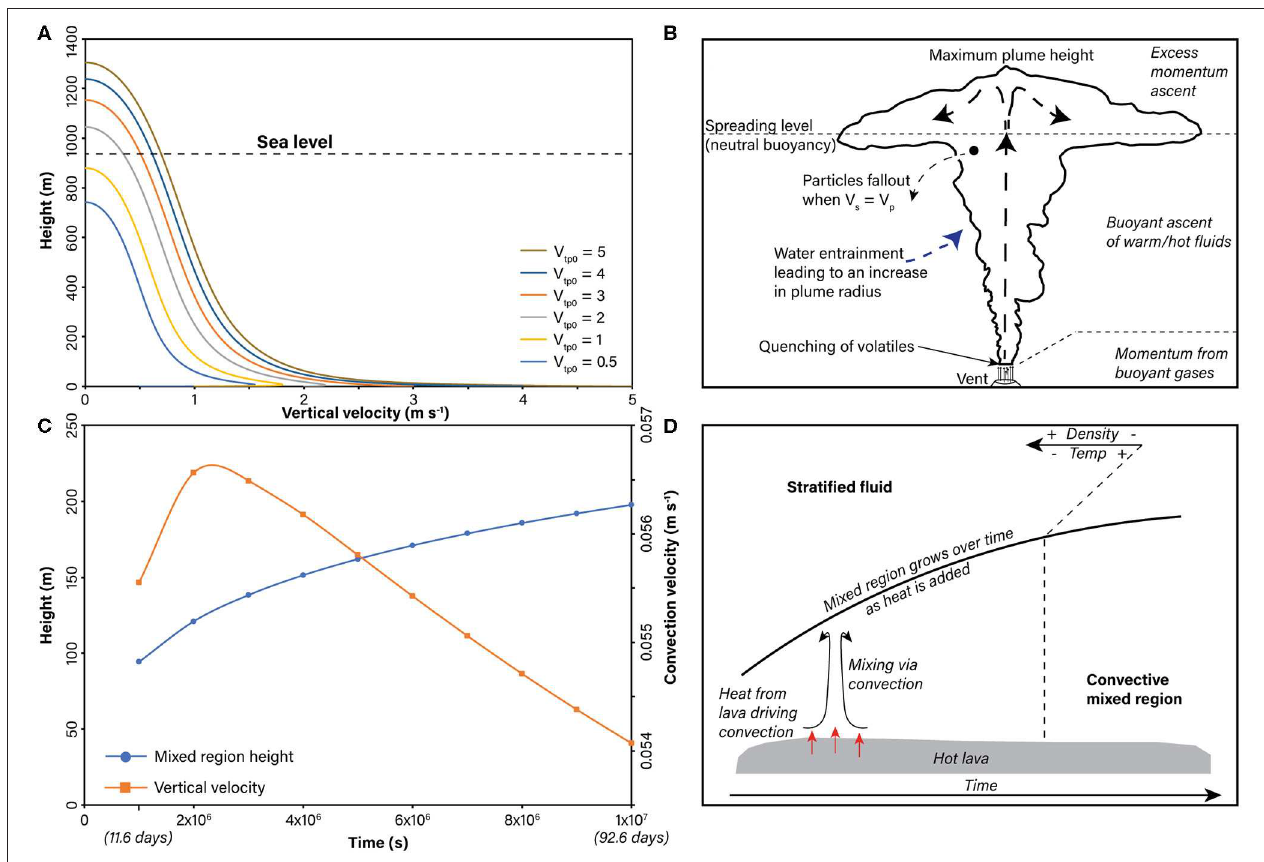
FIGURE 10 | Vertical velocity results for both a turbulent plume and penetrative convection, and schematic diagrams of the physical processes driving convection and dispersal. (A) Vertical velocity profiles through turbulent plumes for a range of V tp0 . Initial values for source area, temperature, and salinity are lain out in the text. The height of the ocean surface above Lava G is shown. The processes occurring in a turbulent plume over its height are illustrated in (B) using the profile of the plume from a source of V tp0 = 5m s − 1 . The height and average vertical velocity of a mixed region generated by penetrative convection over time are shown in (C) . The source conditions are included in Table 3 . (D) Diagram outlining the process by which convection above a lava flow leads to the generation and growth of a zone of convective mixing in an originally stratified